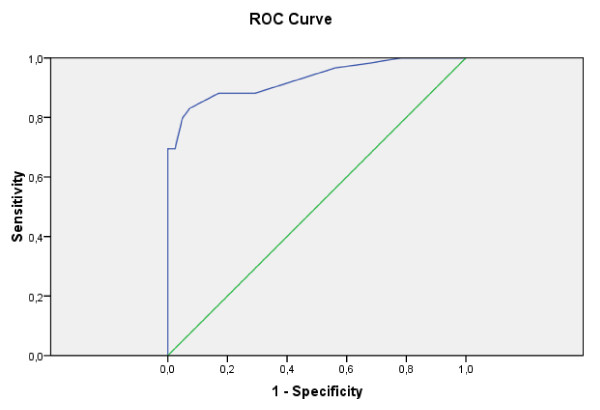
Receiver-operator characteristics (ROC) curve for end-tidal carbon dioxide.